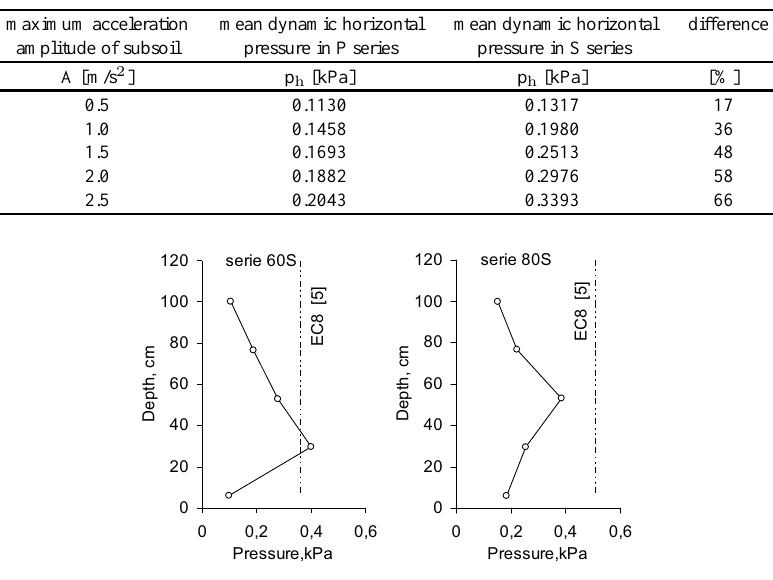
Fig. 10. Distribution of maximal dynamic pressures for S series